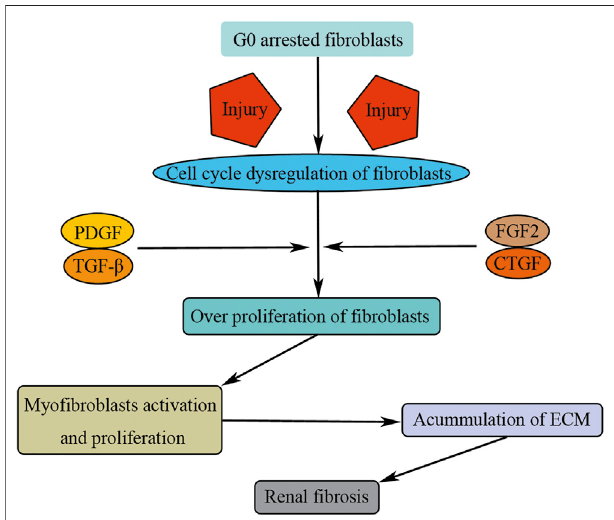
FIGURE 6 | Cell cycle dysregulation of fi broblasts induces renal fi brosis. Injuries result in G0 arrested fi broblast activation and entry into cell cycle. Growth factors (PDGF, TGF- β , FGF2, and CTGF) promote fi broblast overproliferation and translate to myo fi broblasts, causing renal fi brosis by consistent accumulation of